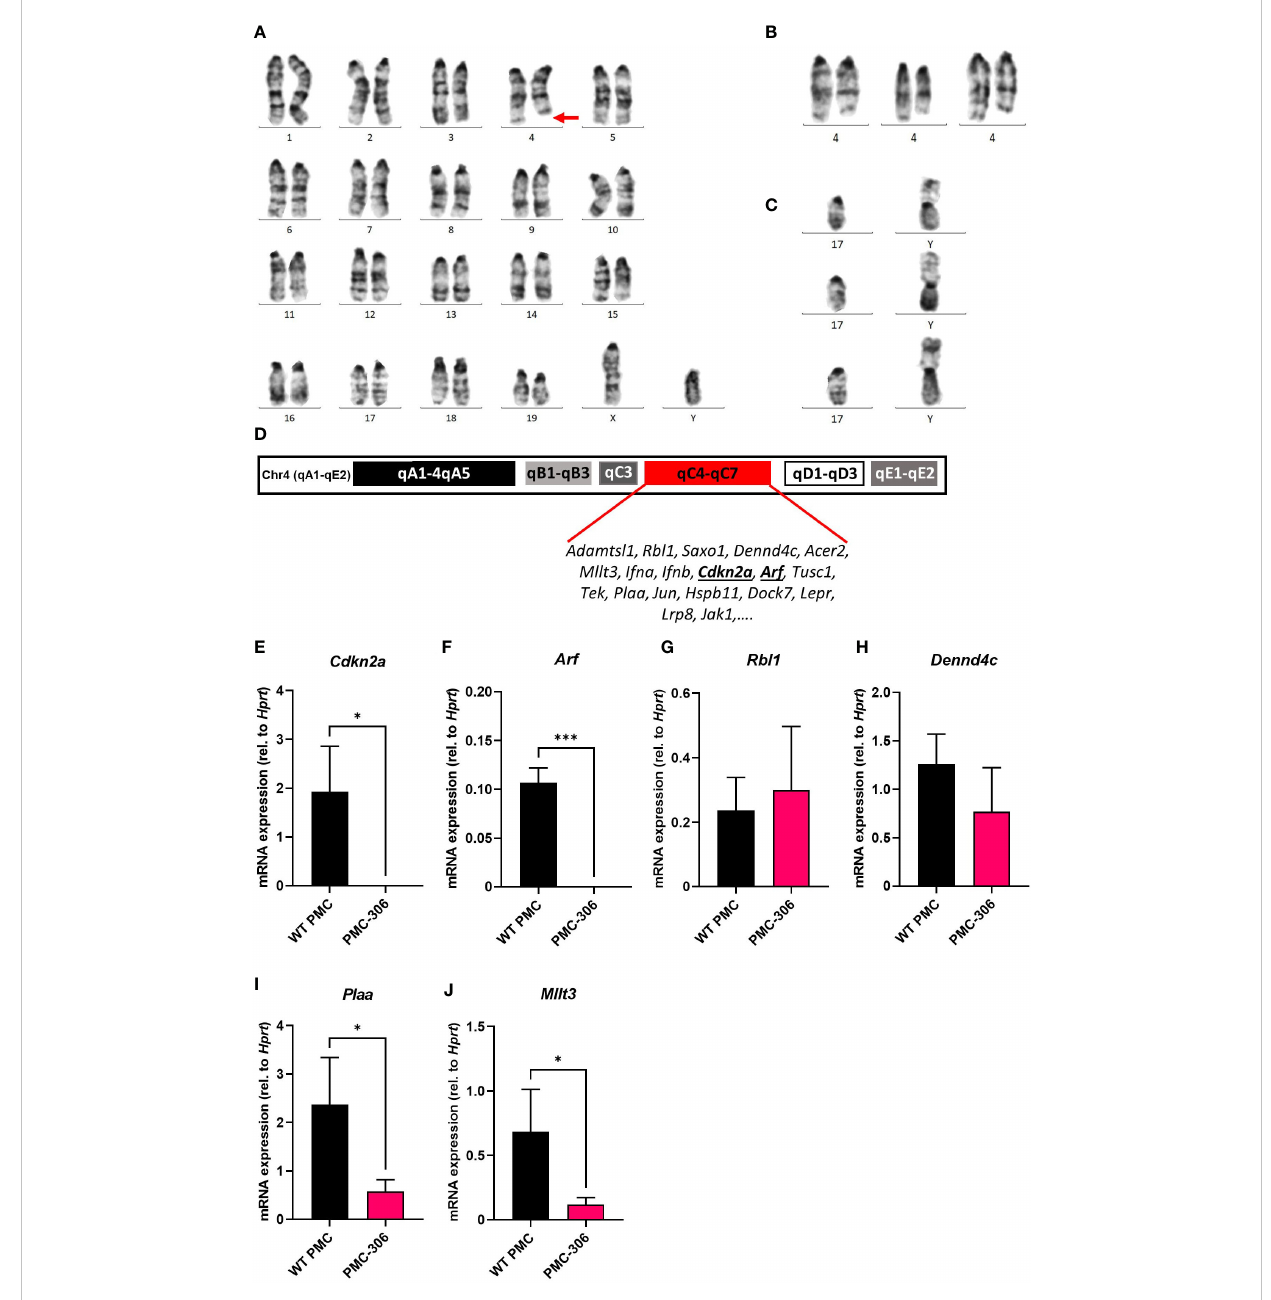
FIGURE 6 Cytogenetic and gene expression analysis identi fi ed loss of Cdkn2a / Arf expression as potential cause for immortalization of PMC-306. Mitotic chromosomes of PMC-306 were cytogenetically analyzed. (A) Representative image of a conventional G-banded karyotype with structural aberration. Red arrow indicates interstitial deletion of chromosome 4 [Del(4)(C4-C7)]. (B) Further examples of partial karyotypes showing structurally aberrant chromosomes 4 with the same interstitial deletion. (C) Three representative partial karyotypes representing the Y-autosome translocation [T (Y;17)] – con fi rmed by fl uorescence in situ hybridization with a Y-speci fi c whole mouse chromosome painting-probe (con fi rmatory FISH analysis not shown)). (D) Architecture of murine chromosome 4 with highlighted region qC4-qC7 and exemplary genes encoded within this region. (E – J) RT- qPCR analysis of Cdkn2a , Arf , Rbl1 , Dennd4c , Plaa and Mllt3 mRNA expression in primary WT PMCs and PMC-306 cells (n=3). Data are expressed as mean +SD. Unpaired, two-tailed Student ’ s t test with Welsh ’ s correction. * p <0.05, *** p